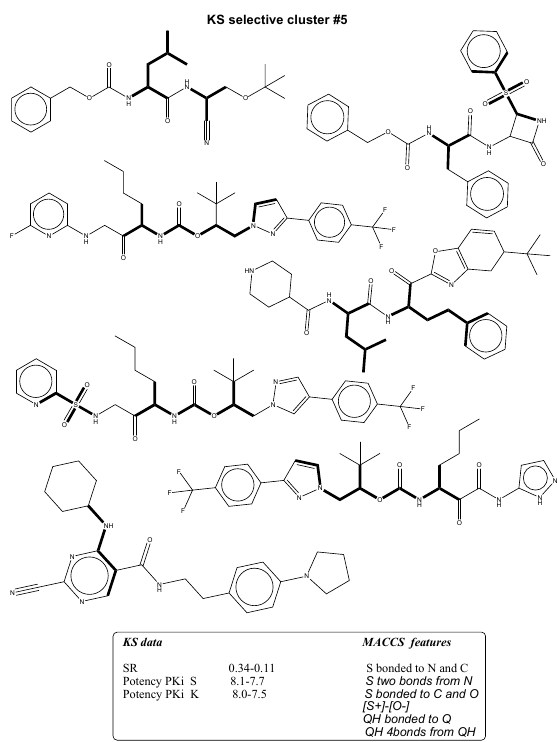
Figure 4. The figure shows mapping of representative MACCS selectivity signatures with high occurrence to K/S selectives presented by bold black highlighting.